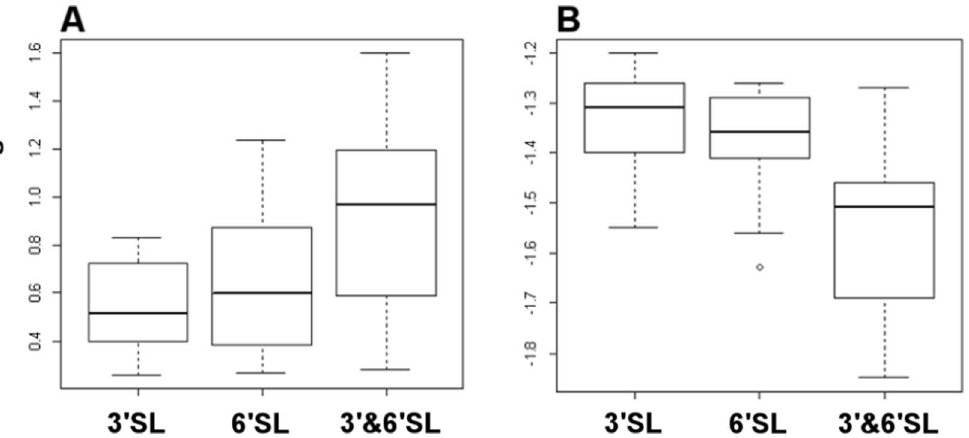
Figure 6. Boxplot representation of the fold-change in expression for the genes up-regulated (A) and down-regulated (B) by all three treatments.